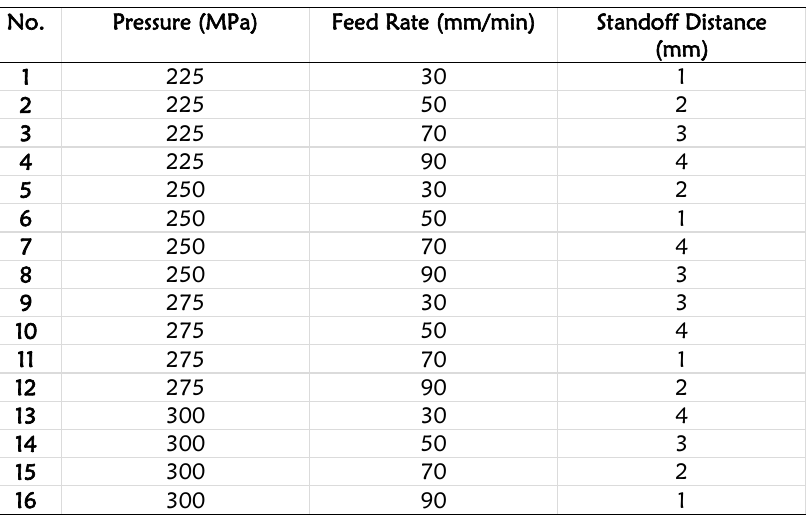
Table 5: experimental